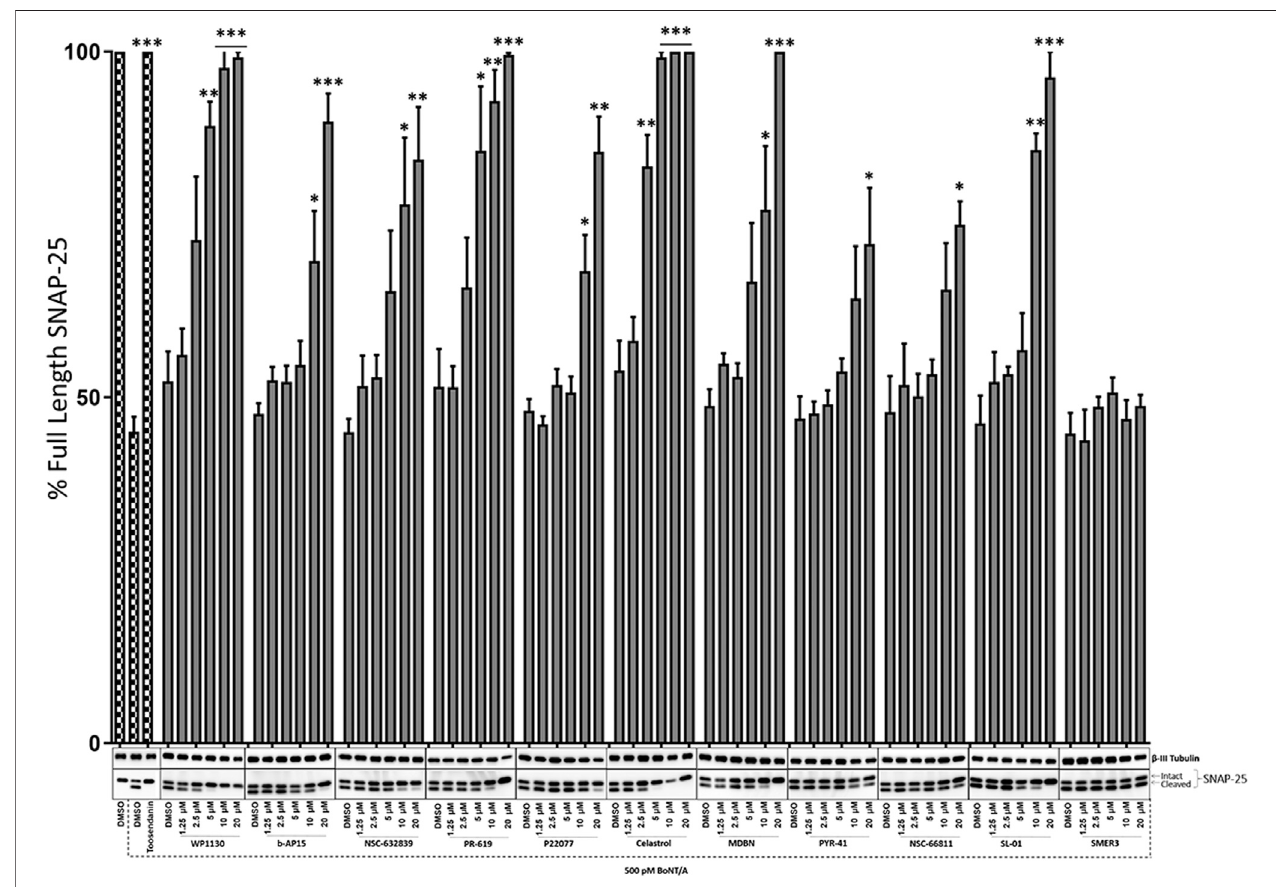
FIGURE 3 | Dose-dependent effects of the selected compounds against BoNT/A holotoxin mediated SNAP-25 cleavage. Mouse ES-cell-derived motor neurons were treated with the compounds at increasing doses (1.25, 2.5, 5, 10, and 20 µM) for 30 min before intoxication with 500 pM BoNT/A holotoxin. The total intoxication time was 4 h. Toosendanin treatment (1 µM) was utilized as a positive control. β -III Tubulin was used as a loading control. Western blots are representatives of three independent experiments, and the data are presented as means ± SEM. +++ , ++ , + Value signi fi cant at 99.9%, 99%, and 95 %con fi dence level, respectively, compared to DMSO + Toxin control condition of each compound